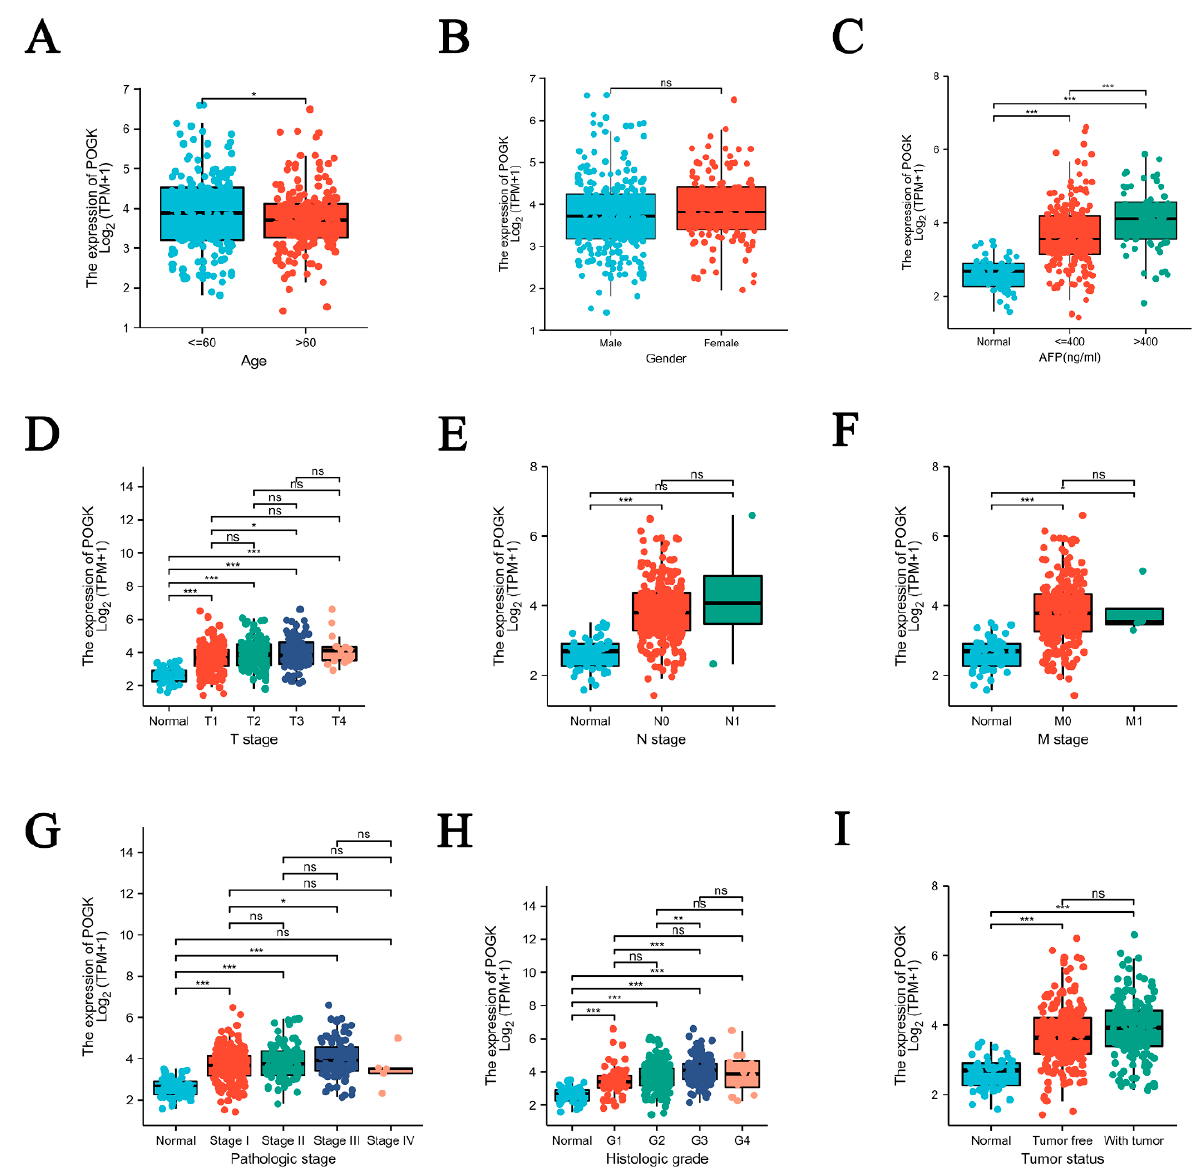
Figure 3. POGK expression of patients with hepatocellular carcinoma according to different clinical characteristics. ( A ) age; ( B ) gender; ( C ) AFP; ( D ) T stage; ( E ) N stage; ( F ) M stage; ( G ) pathologic stage; ( H ) histologic grade; ( I ) tumor status. ns: no significant; *: p < 0.05; **: p < 0.01; ***: p < 0.001.